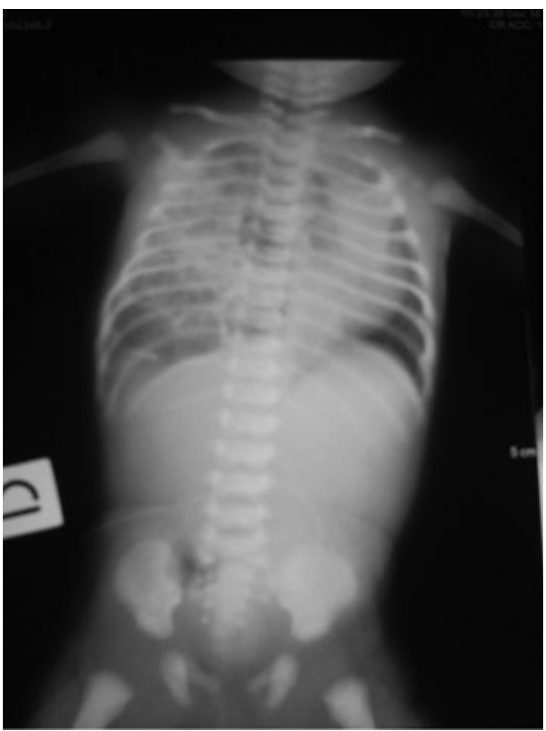
Fig. 1 Chest radiograph documenting right diaphragmatic hernia.